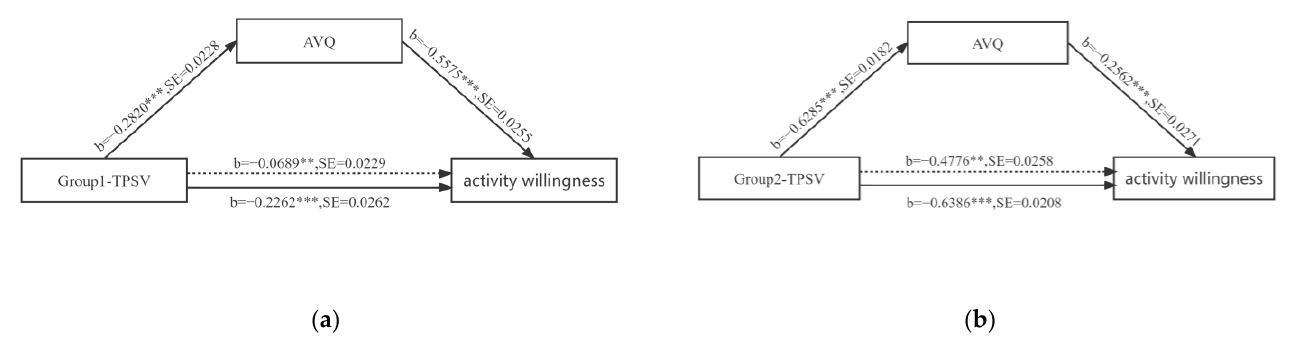
Figure 3. Mediating effect between TPS and LQE’s activity willingness in Group 1 (b is the standardized regression coefficient; SE is the standard error). ( a ) Mediating effect of LQE between TPS and activity willingness in Group 1; ( b ) Mediating effect of LQE between TPS and activity willingness in Group 2 (b is the standardized regression coefficient; SE is the standard error). (Note: *** p ≤ 0.001, ** p ≤ 0.01). Table 12. The mediating role of LQE between TPS and activity willingness in two groups.